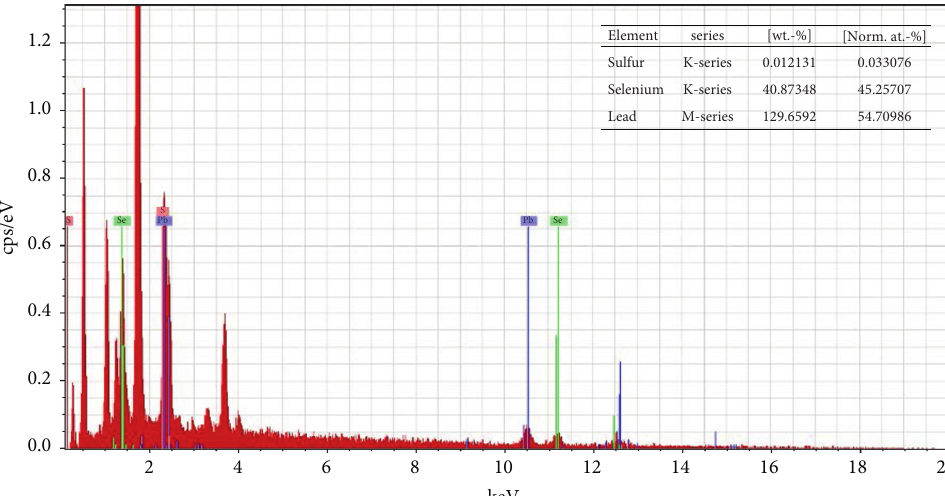
Figure 5: EDAX spectrum of thin films deposited from [Pb((SeP i Pr composition of the thin